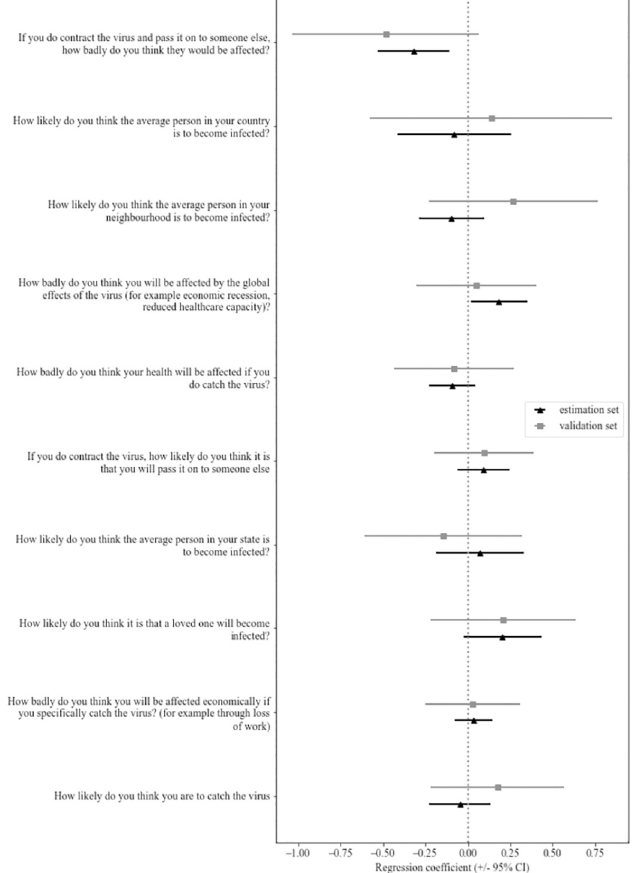
Fig 3. Results of linear regression predicting the intention of leaving home from risk perception measures, with validation in a subsample of 20% of the subjects.